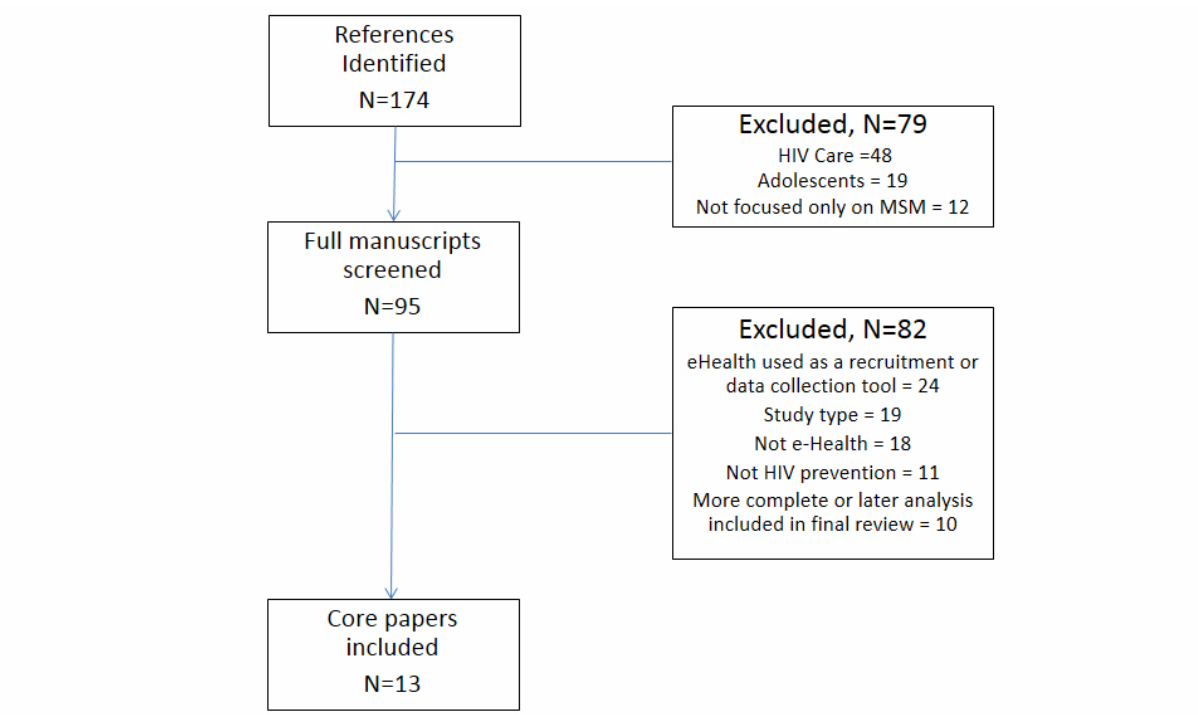
Figure 1. Screening process